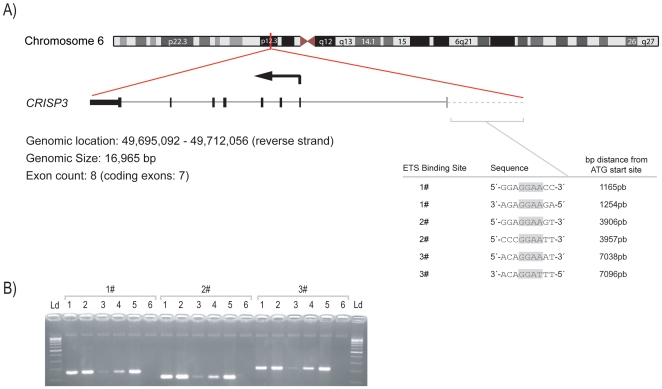
Chromatin immunoprecipitation of CRISP3 promoter with ERG antibody.A) Schematic representation of CRISP3 gene showing the sequence of three ETS binding sites found in the CRISP3 promoter, each with two putative consensus binding sequences. Shadowed letters show the ETS core motif GGAA/T. B) CRISP3 promoter amplification after chromatin immunoprecipitation with ERG antibody; specific amplification of the three ETS binding sites is shown; From left to right: Ld-100 bp DNA ladder, 1- “input” chromatin, 2- ChIP with Anti-RNA polymerase II antibody (positive control), 3- ChIP with Mouse IgG antibody (negative control), 4- ChIP with ERG antibody (#EPR3864), 5- Total DNA from VCaP cells, 6- Blank.